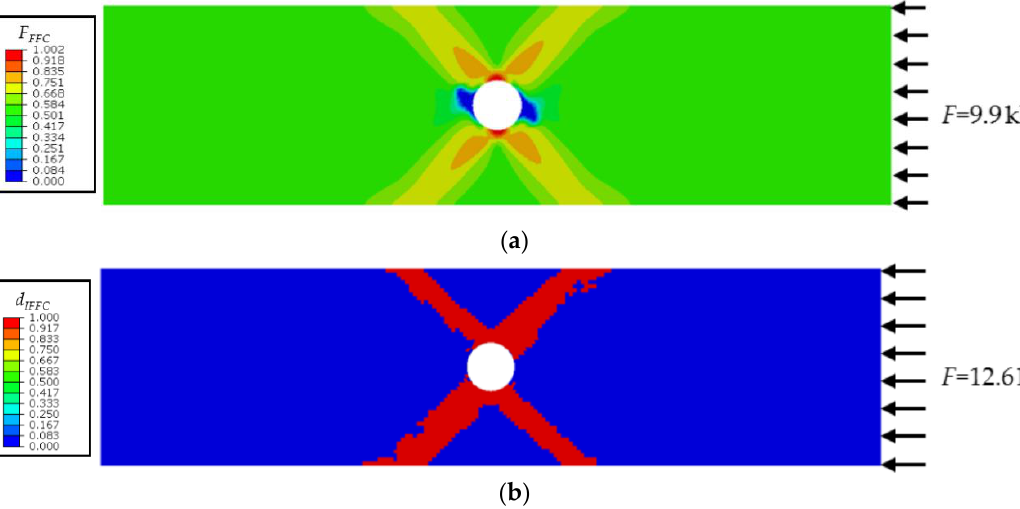
Figure 13. Progressive failure process of the CFRP laminate under compression. ( a ) IFFC initiates in a 45° ply; ( b ) Damage variable d IFFC in a 45° ply.